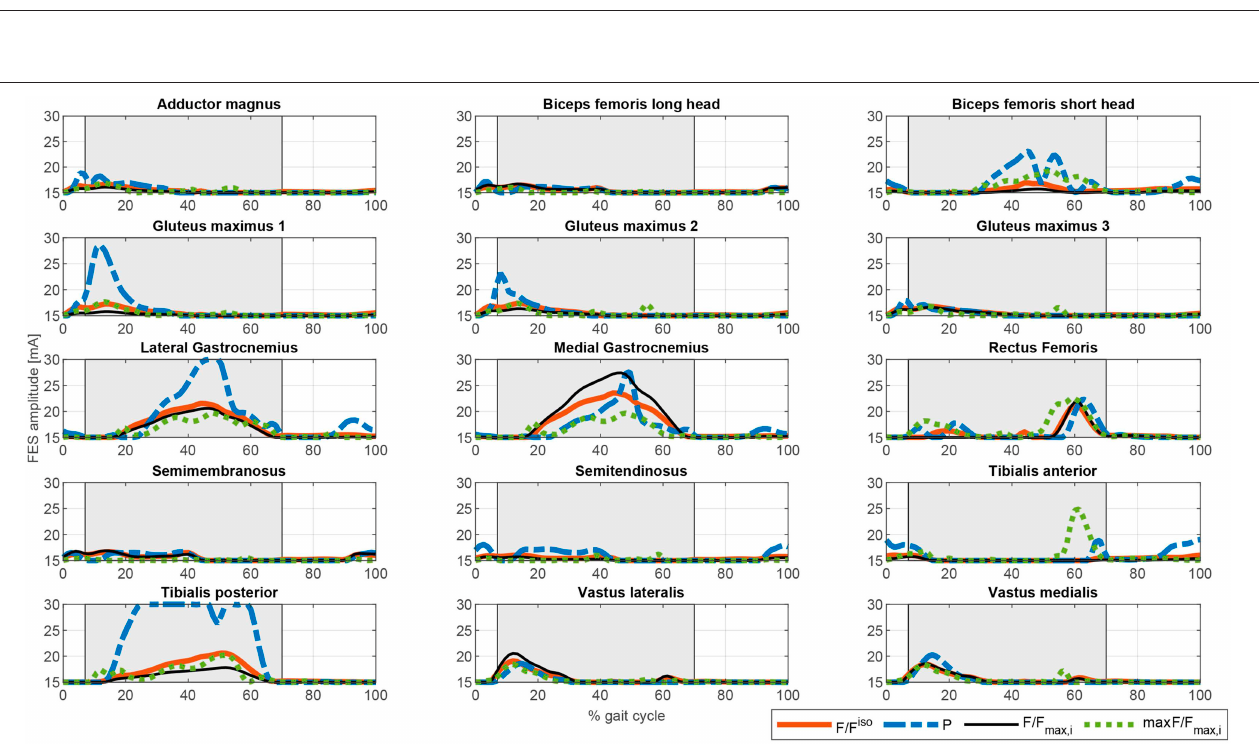
FIGURE 5 | Comparison of the different FES profiles for the proposed optimization cost functions. CF1: Thick solid orange line. CF2: Dashed blue line. CF3: Thin solid black line. CF4: Dotted green line.